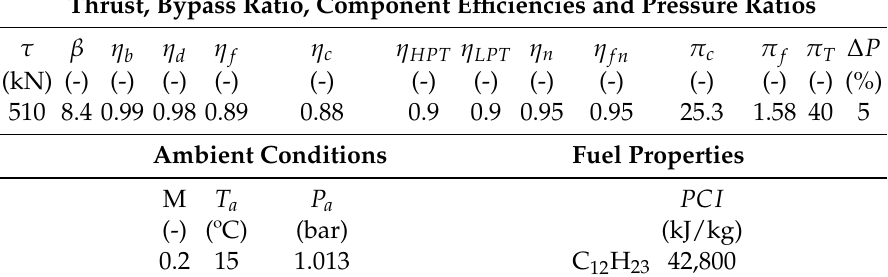
Table 5. Technical design data of the GE90-115B [40]: component efficiencies, pressure ratios, ambient conditions, and fuel properties